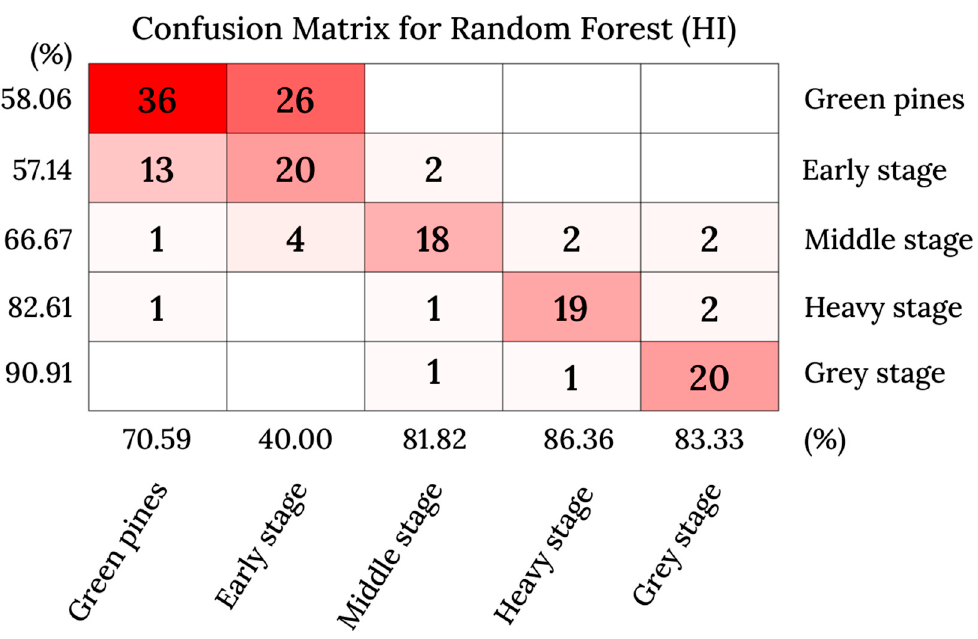
Figure 11. Confusion matrix made by Yu et al. (2021) [92] to evaluate the performance of the classification algorithm on the five stages of PWD infection.